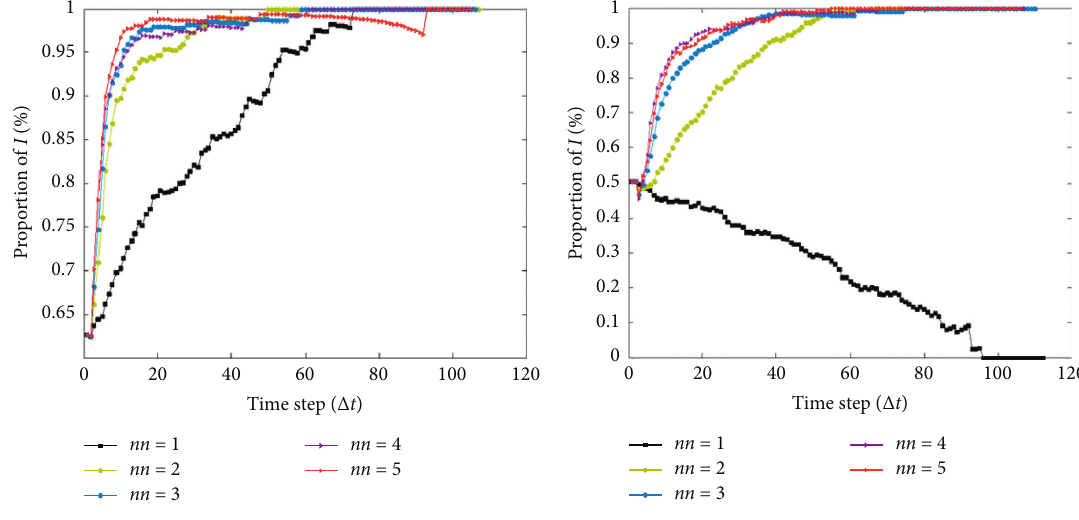
Figure 18: Proportion of state group I under different perception radius when N � 200. (a) λ � 0 . (c) λ emotion